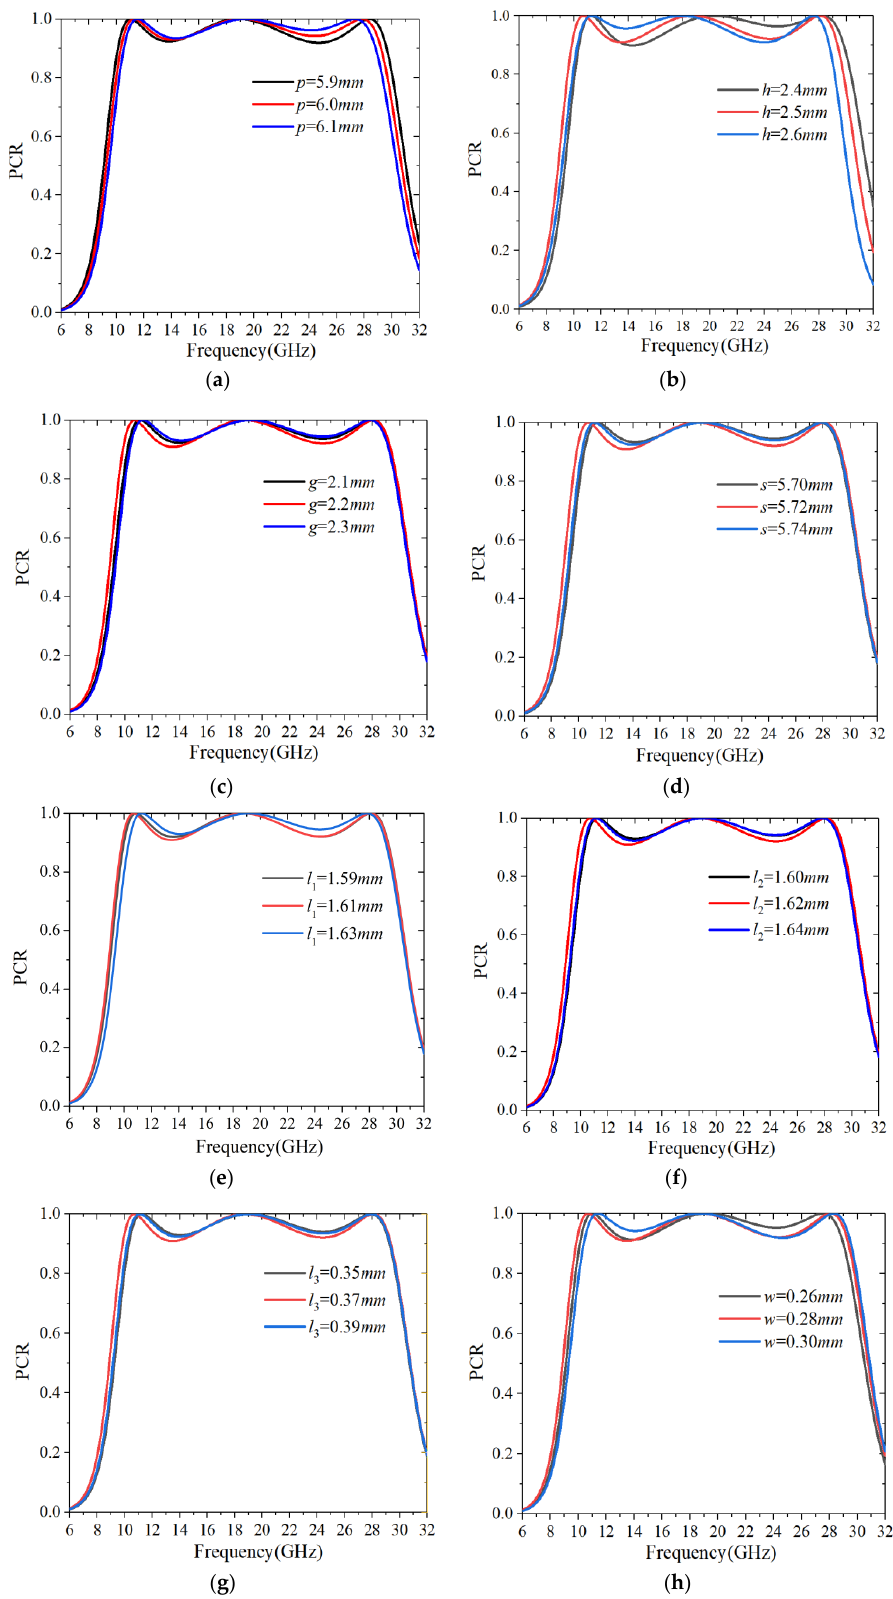
Figure 10. The PCR variation dependence on different parameters of the unit cell. ( a ) p ; ( b ) h ; ( c ) g ; ( d ) s ; ( e ) l 1 ; ( f ) l 2 ; ( g ) l 3 ; ( h ) w .